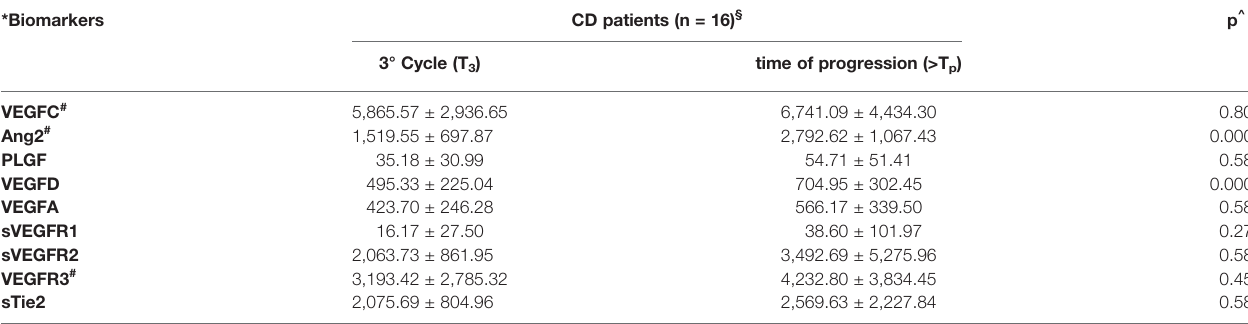
TABLE 4 | Trend of serological biomarkers from the fi rst radiological evaluation to time of